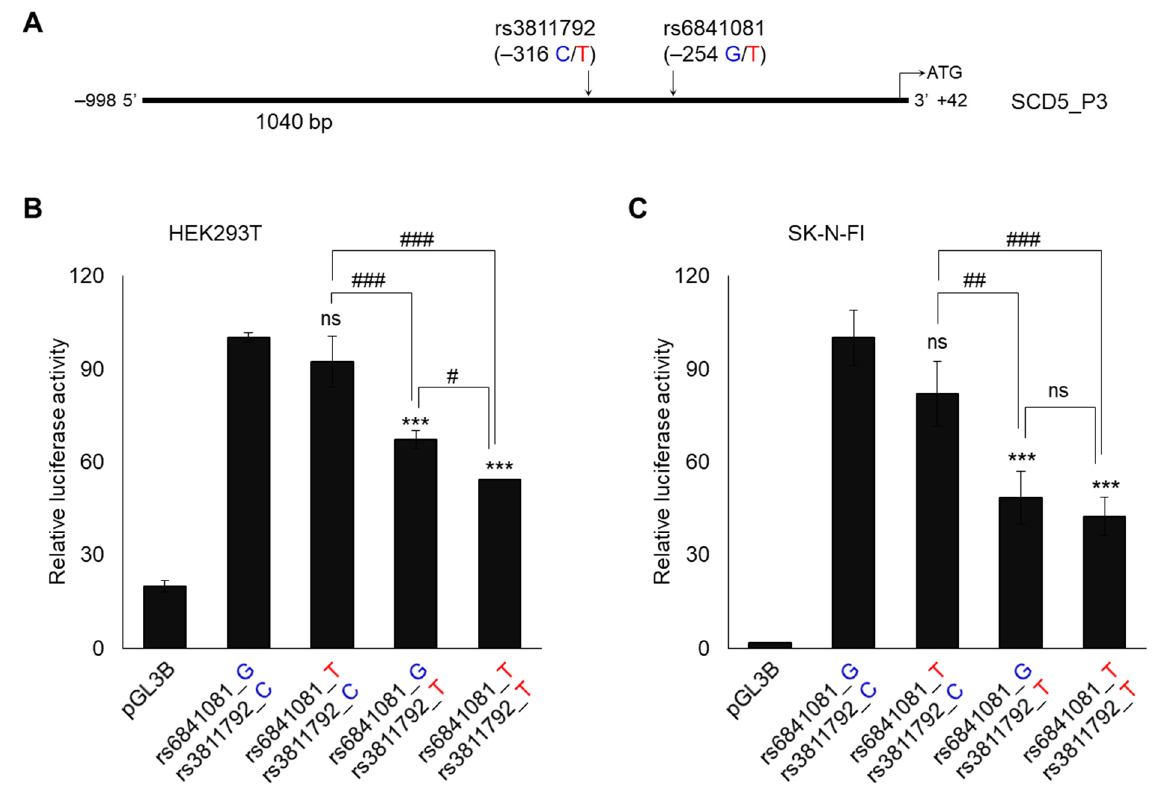
Figure 4. Position ( A ) and effect of two polymorphisms on relative SCD5 promoter activity in HEK293T ( B ) and SK-N-FI ( C ) cells. ( A ) The position of two polymorphisms is marked on SCD5 5 ′ regulatory region and numbered from the translation start site (+1). Transfection was performed as described in Section 2. pCMV- β -gal vector served as transfection control. Luciferase and β -galactosidase enzyme activities were measured as indicated in Section 2 and their relative ratios are shown as bar graphs. The diagram depicts the results of three independent measurements normalized to the SCD5_P3 with the highest activity. Data are shown as mean values ± S.D. Statistical analysis was performed by using the Tukey–Kramer Multiple Comparisons Test. #: p < 0.05; ##: p < 0.01; *** or ###: p < 0.001; ns: not significant.